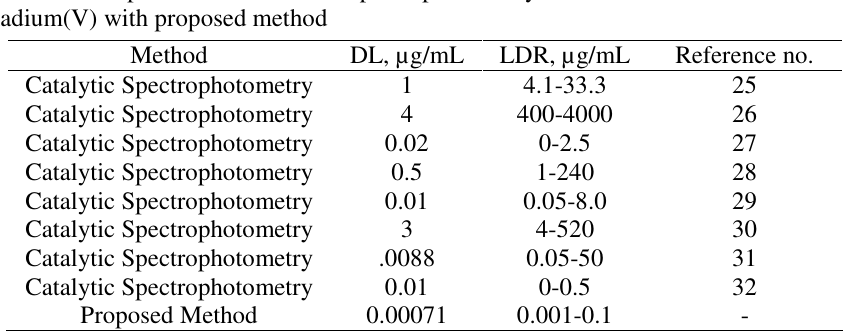
Table 4. Comparison of kinetic spectrophotometry methods for determination of Vanadium(V) with proposed